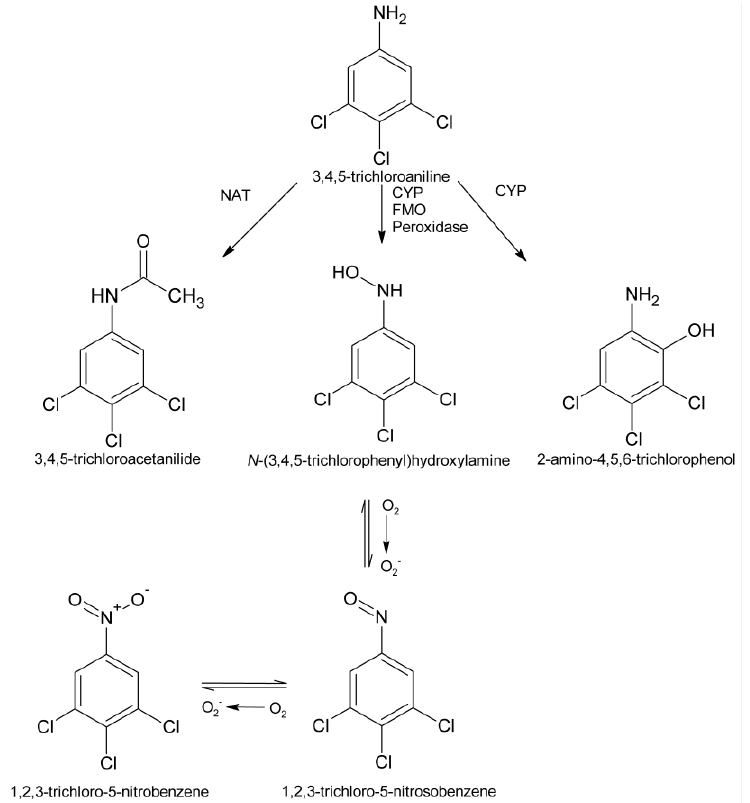
Figure 5. Potential metabolic pathways for TCA. NAT, N -acetyltransferase; CYP, cytochrome P450; FMO, flavin-containing